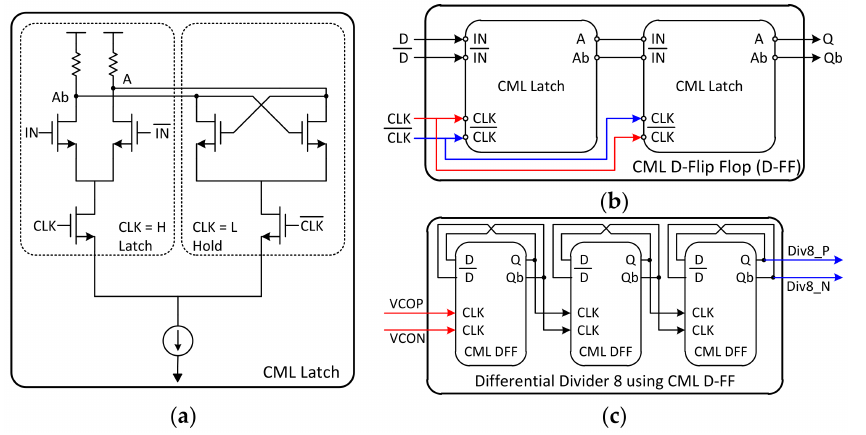
Figure 12. The detailed schematic of the differential divider, expressed up to the basic device level. The schematic of the CML latch is shown in ( a ); and the CML D-FF is described in ( b ); The schematic of the differential divider is illustrated in ( c ).